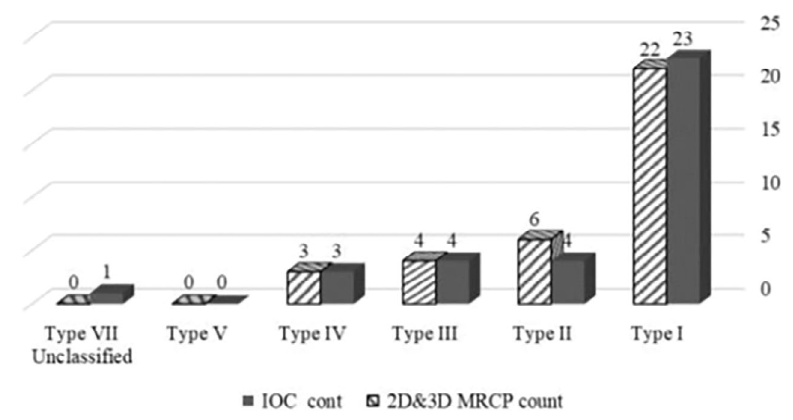
Figure 1. Pars presentation of diagnostic accuracy of MRCP and IOC.